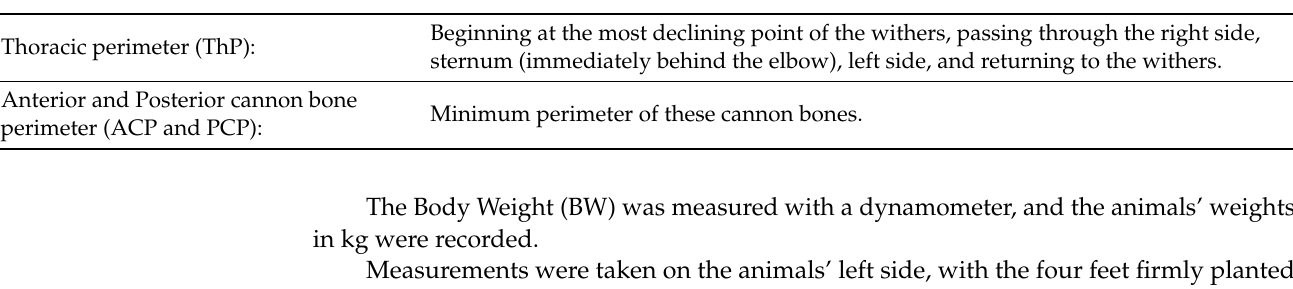
Table 3. Measurements taken using a flexible